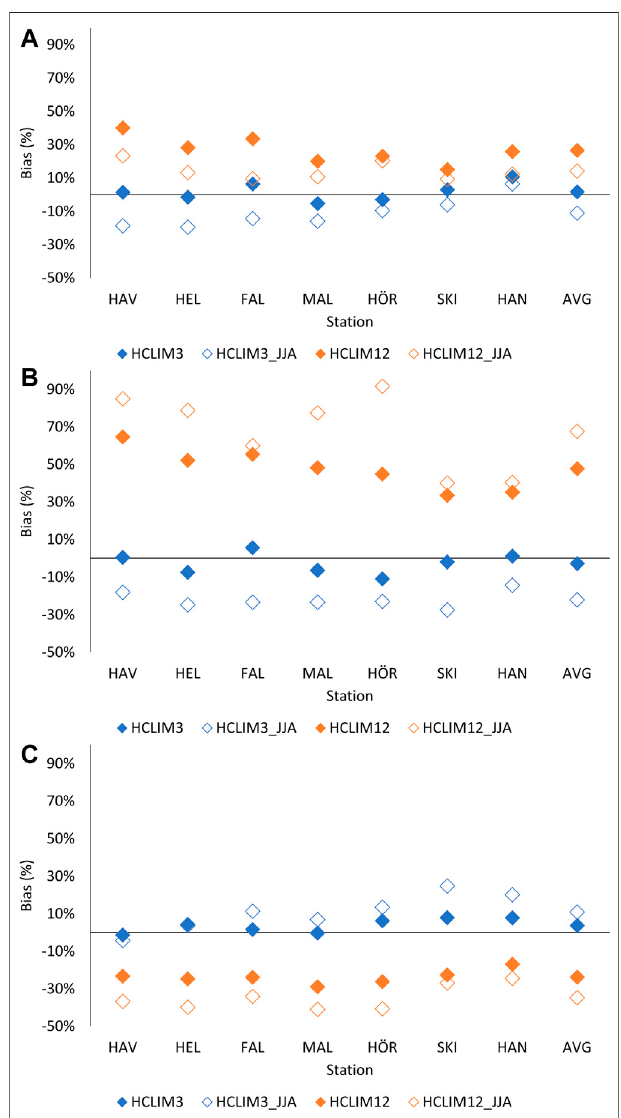
FIGURE 4 | Bias of 1-h rainfall of HCLIM3 and HCLIM12 in each station: total monthly precipitation R tot (A) , wet fraction F wet (B) and wet intensity I wet (C) . Diamonds with fi lled color denote annual averages, diamonds without fi ll denote summer (June – August) averages.